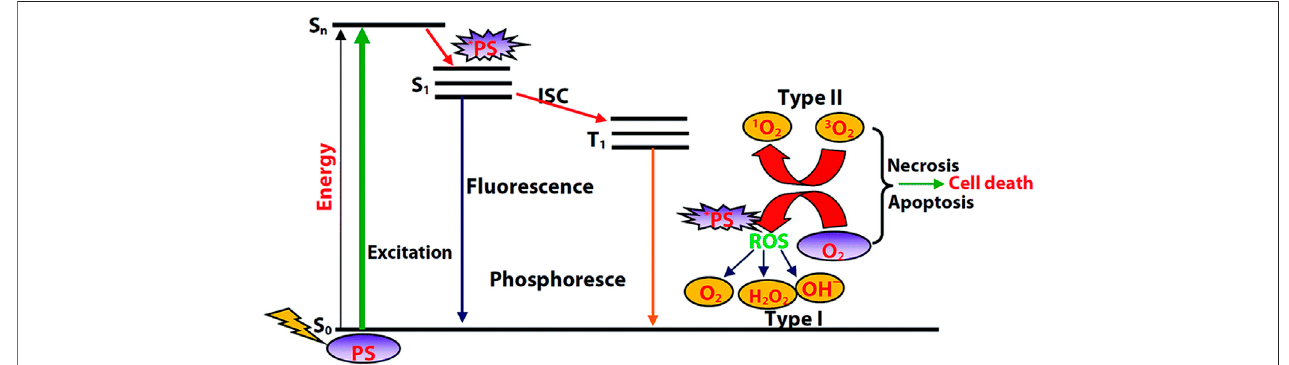
FIGURE 1 | Diagram illustrating the process of PDT. Reprinted with permission from Majumdar et al. (2014).